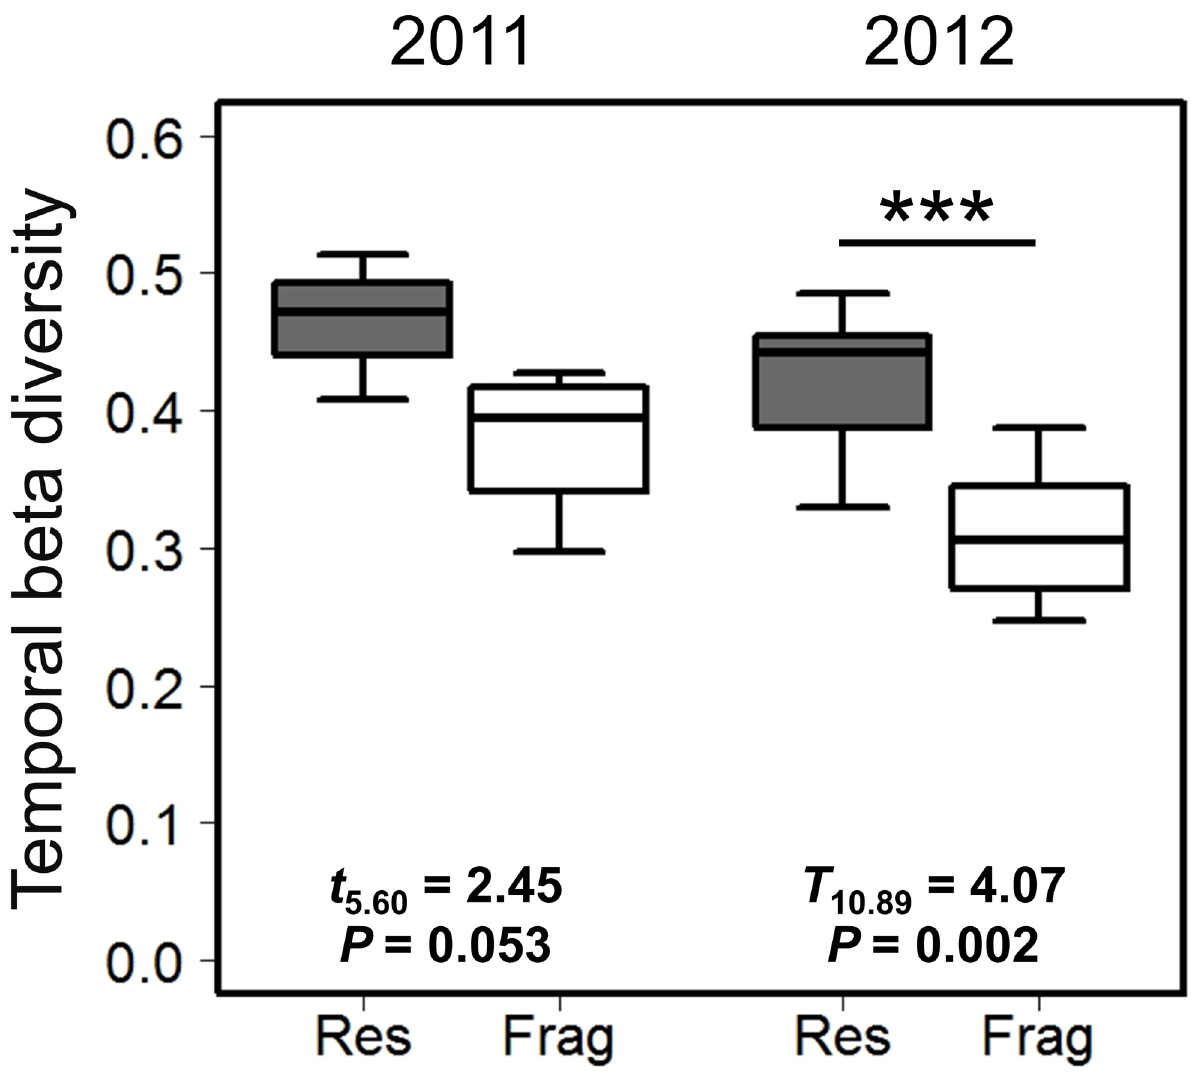
Fig 4. Temporal beta diversity of native bees in reserve(gray boxes) and fragment plots (white boxes). Beta diversity was calculatedas the multivariatedispersion of abundance-weighted bee assemblagesin distinct temporalsamples within each study plot. Boxes, whiskers, and asterisks are as in Fig